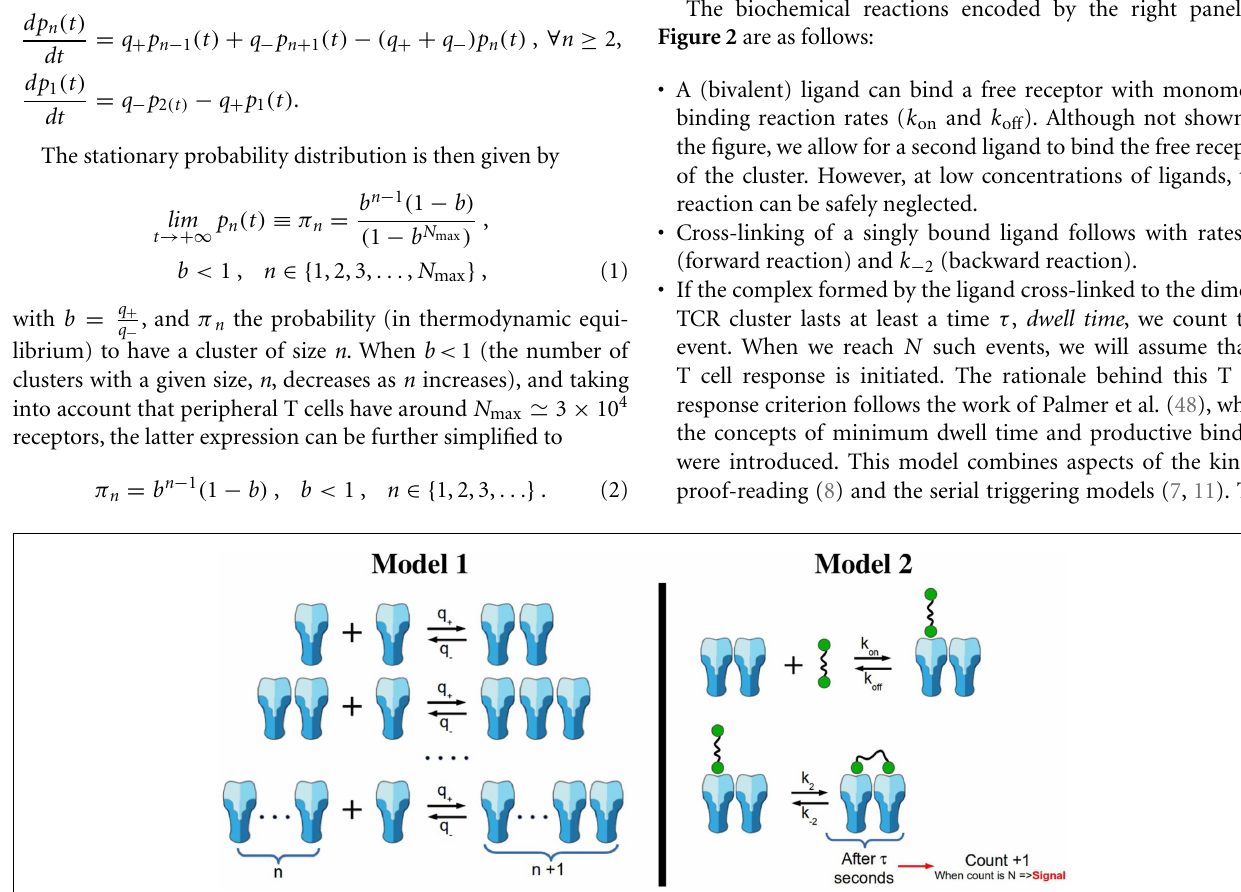
attach monovalently to any receptor in a cluster (top reaction). In addition, ligand-inducedTCR cross-linking can occur once a ligand is bound to aTCR in a given nano-cluster (bottom reaction). Following Ref. (26), once the bivalently bound ligand has been attached for a time τ , we count that state as a signaling unit. After N of these units have been generated, the cell becomes